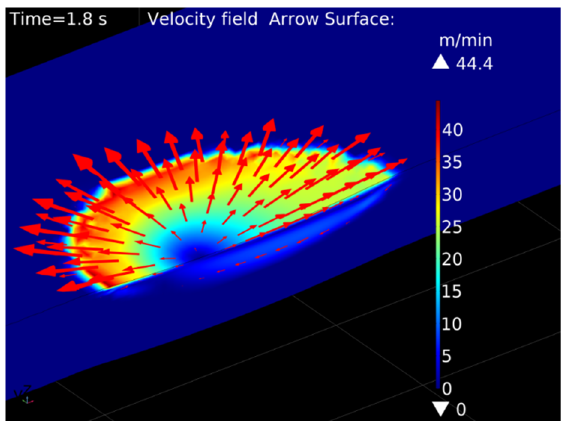
Figure 11. Velocity field of melt pool motion, computed by the fluid flow model for P = 1000 W, v = 400 mm/min, T = 20 °C. v = 400 mm/min, T = 20 ◦ C.